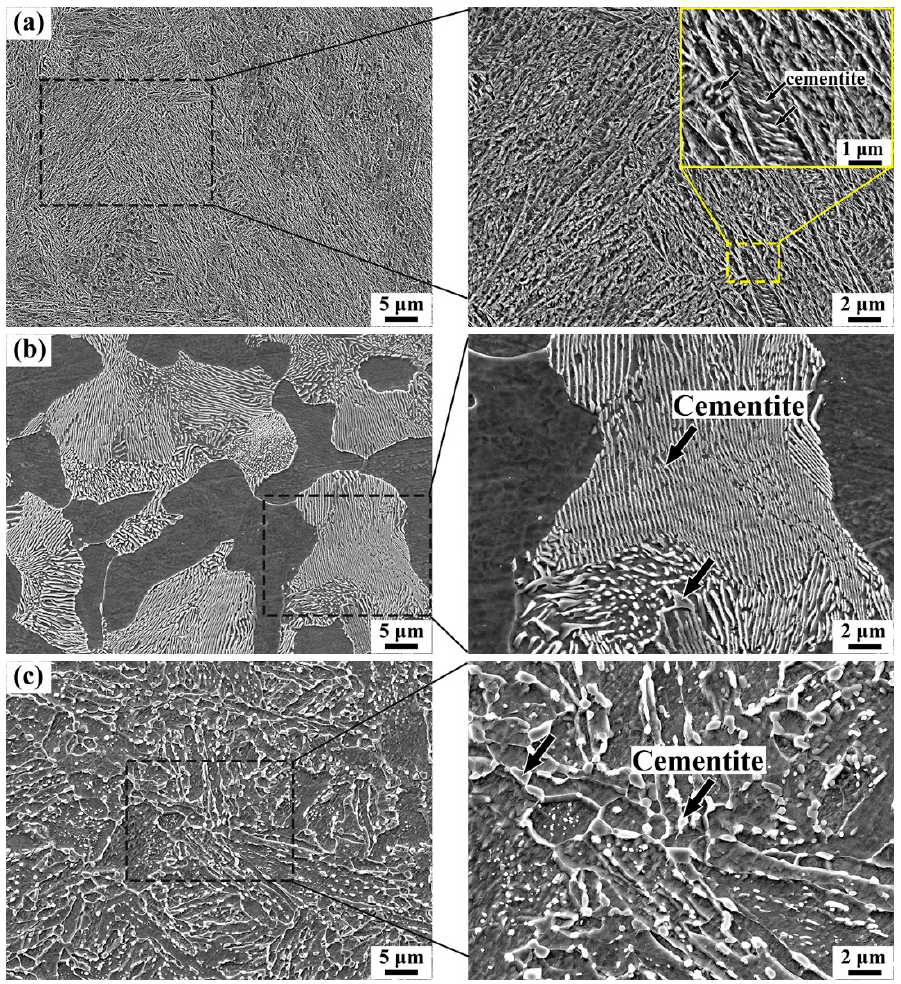
Figure 2. SEM micrographs of the specimens through different heat treatments. ( a ) QT, ( b ) NT, and ( c ) ST.